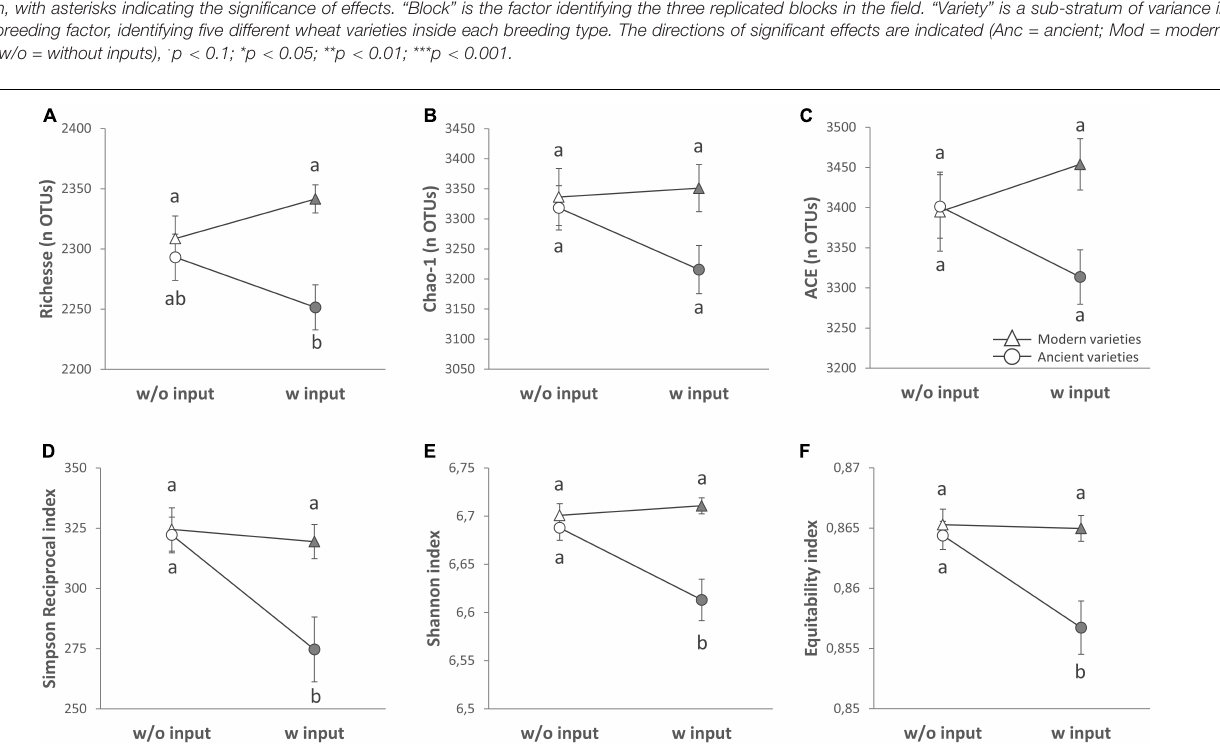
FIGURE 1 | Alpha diversity of the rhizosphere bacterial community (16S rRNA gene amplicon sequencing) presented as reaction norms of ancient and modern wheat genotypes to environment modification by inputs. Panels are respectively showing: the (A) richness, (B) Chao-1 estimator, (C) ACE estimator, (D) Simpson Reciprocal index, (E) Shannon index, and (F) Pielou’s equitability. Data are shown as the interaction between breeding type and the presence/absence of inputs (w/o: without inputs; w: with inputs, N = 11–14 per treatment, error bars are standard error of the mean). Significance was inferred with an ANOVA under Tukey’s HSD post hoc test for normally distributed data (honest significant differences, p < 0.05). Data that were not normally distributed were analyzed by Scheirer-Ray-Hare test followed by post hoc false discovery rate test correction to account for multiple testing (FDR, p <